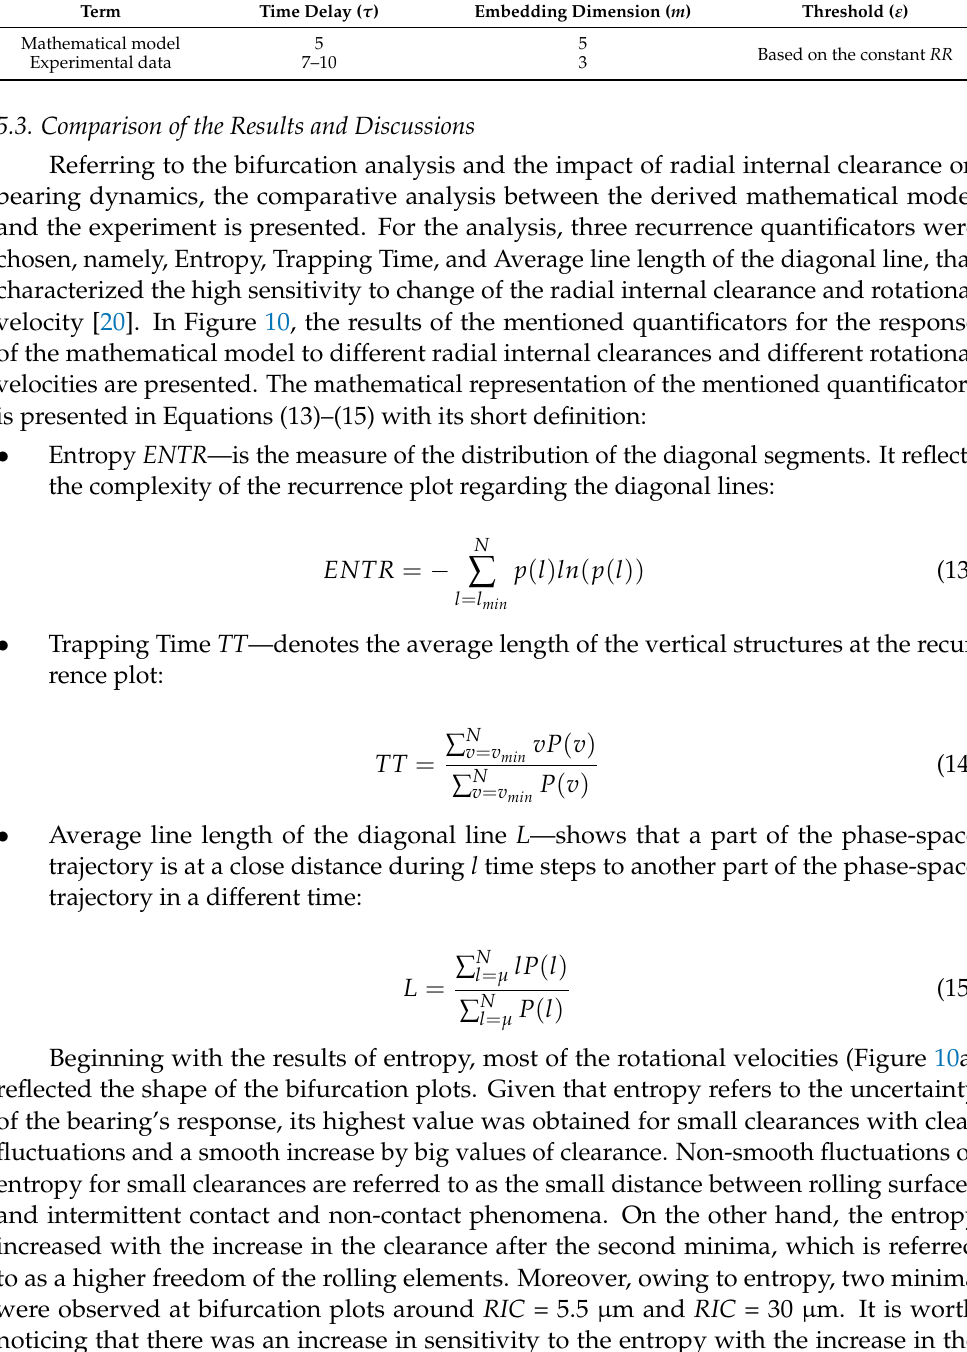
Table 2. Phase-space reconstruction parameters selected for the mathematical model and experimen- tal data. Term Time Delay ( τ ) Embedding Dimension ( m ) Threshold ( ε ) Mathematical